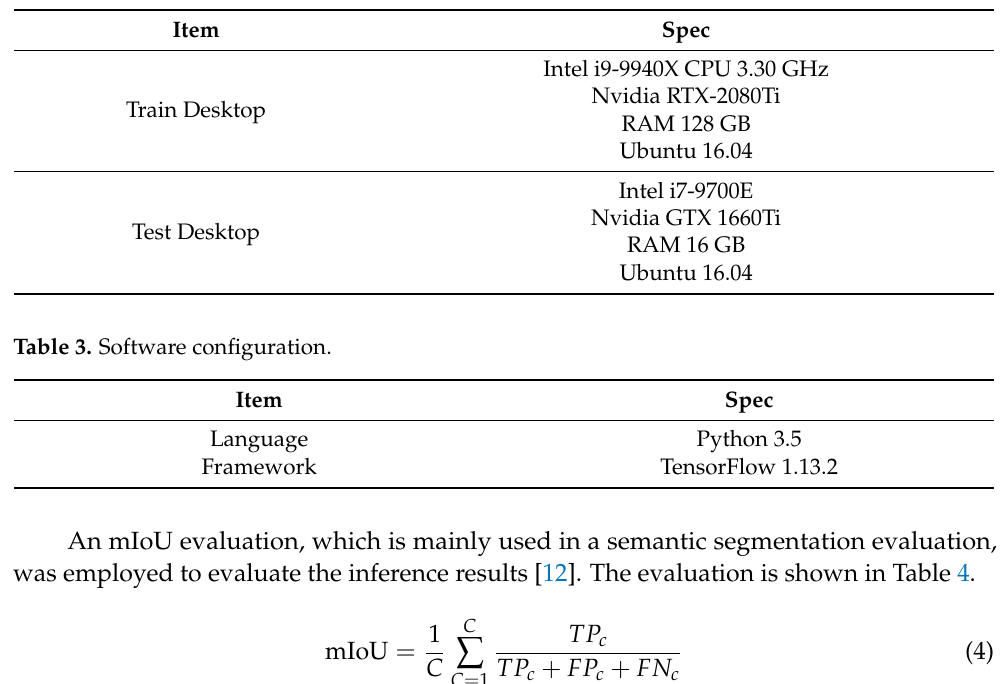
Table 2. Hardware configuration.